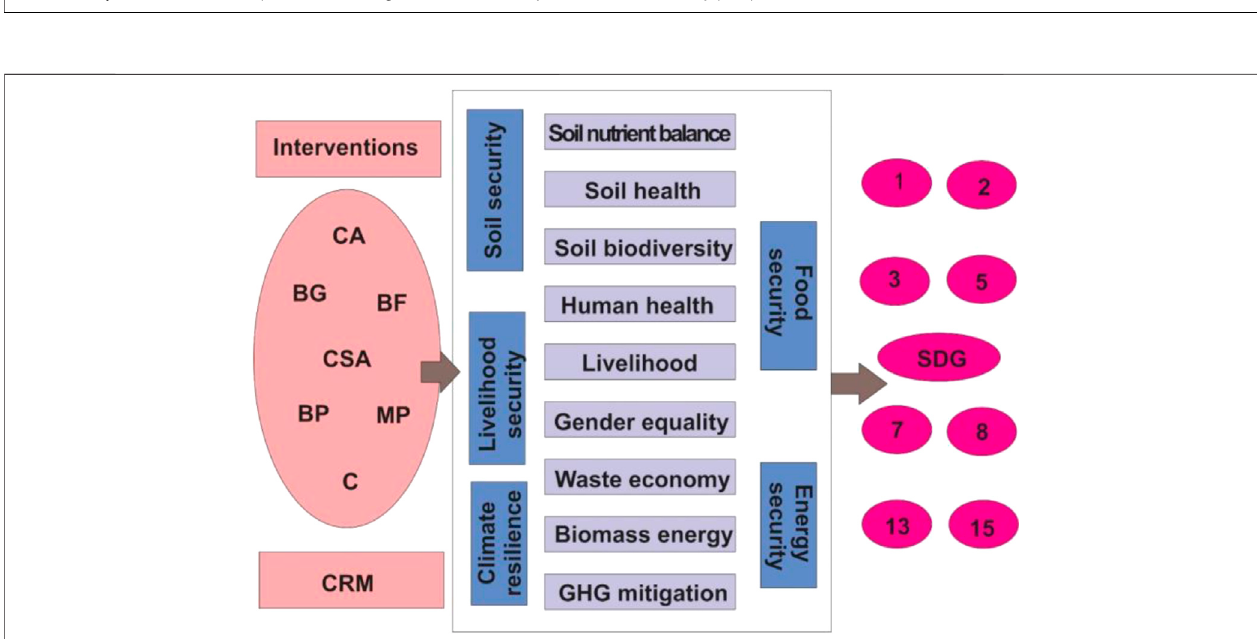
FIGURE 8 | Mapping of bene fi ts of bioeconomy driven interventions in crop residue management. Abbreviations: CA, Conservation Agriculture; CSA, Climate Smart Agriculture; C, Composting; BF, Biofuel; BP, Biochar Production; BG, Biogas; MP, Mushroom Production.